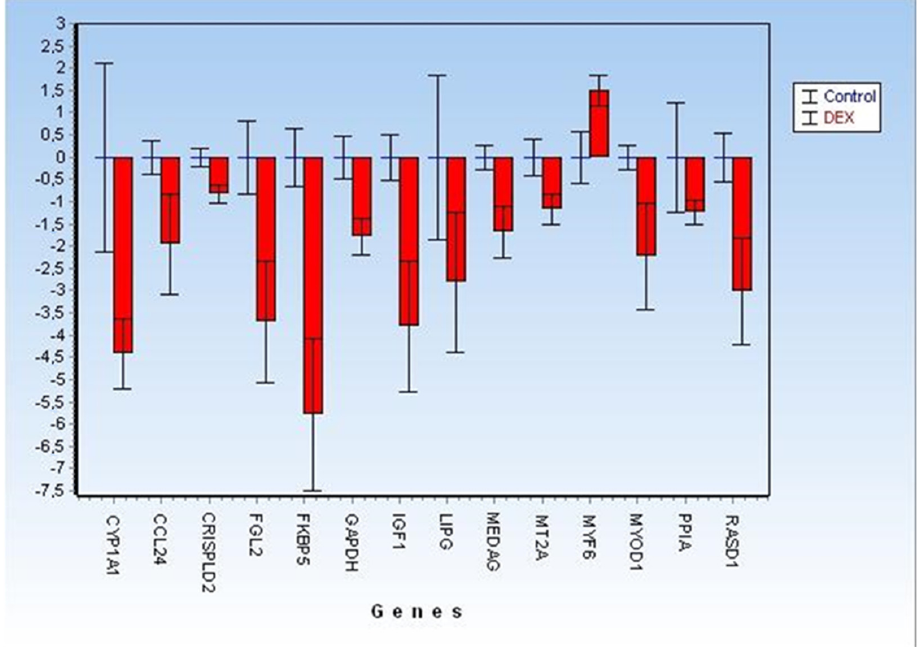
Figure 3. Detailed Fold Changes (±CI at 95%) of 12 significant differentially expressed genes (represented as green and yellow dots, respectively, in Figure 2) plus two targets (PPIA and GAPDH) analysed for reference-genes selection.